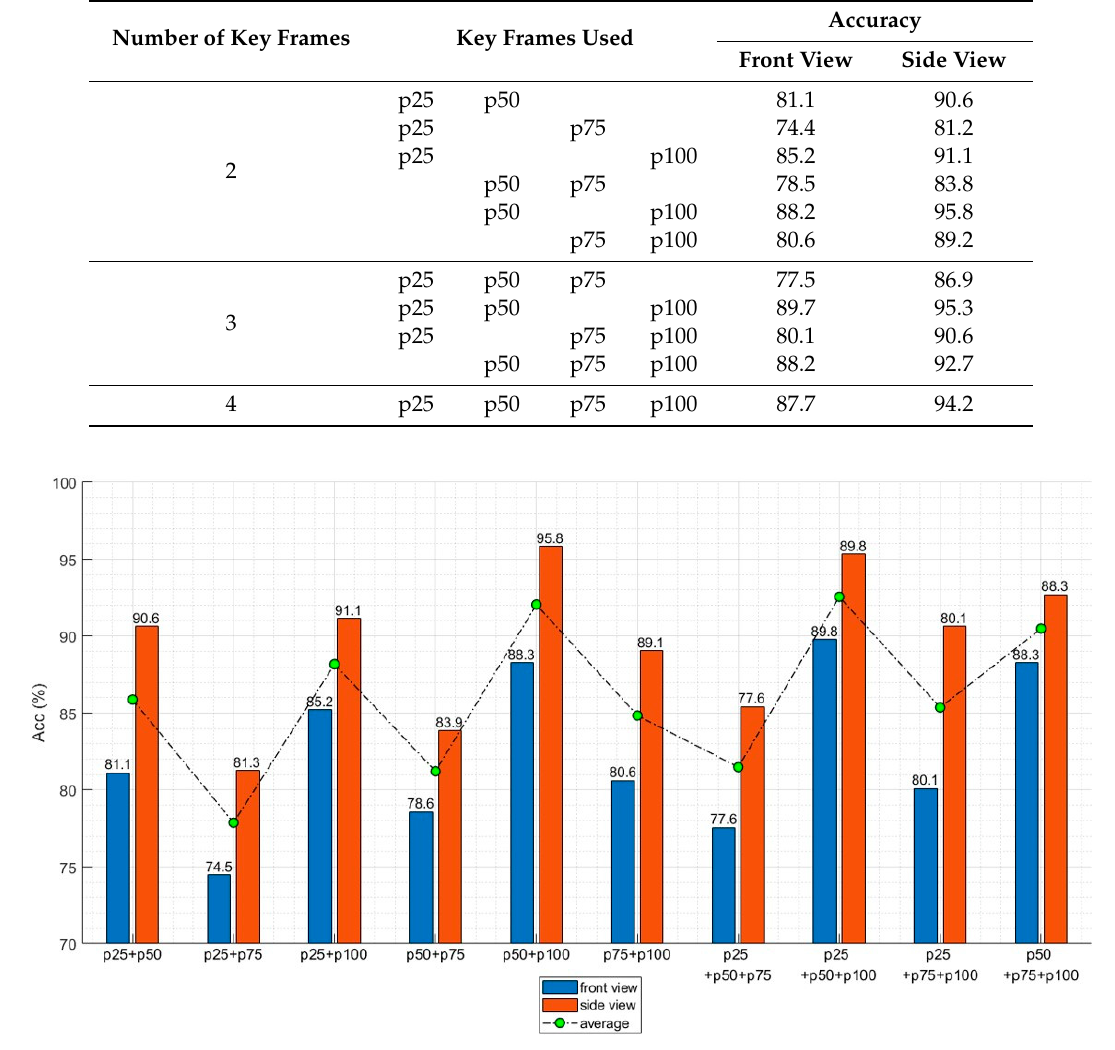
Figure 11. Recognition accuracy according to the selected key frames.